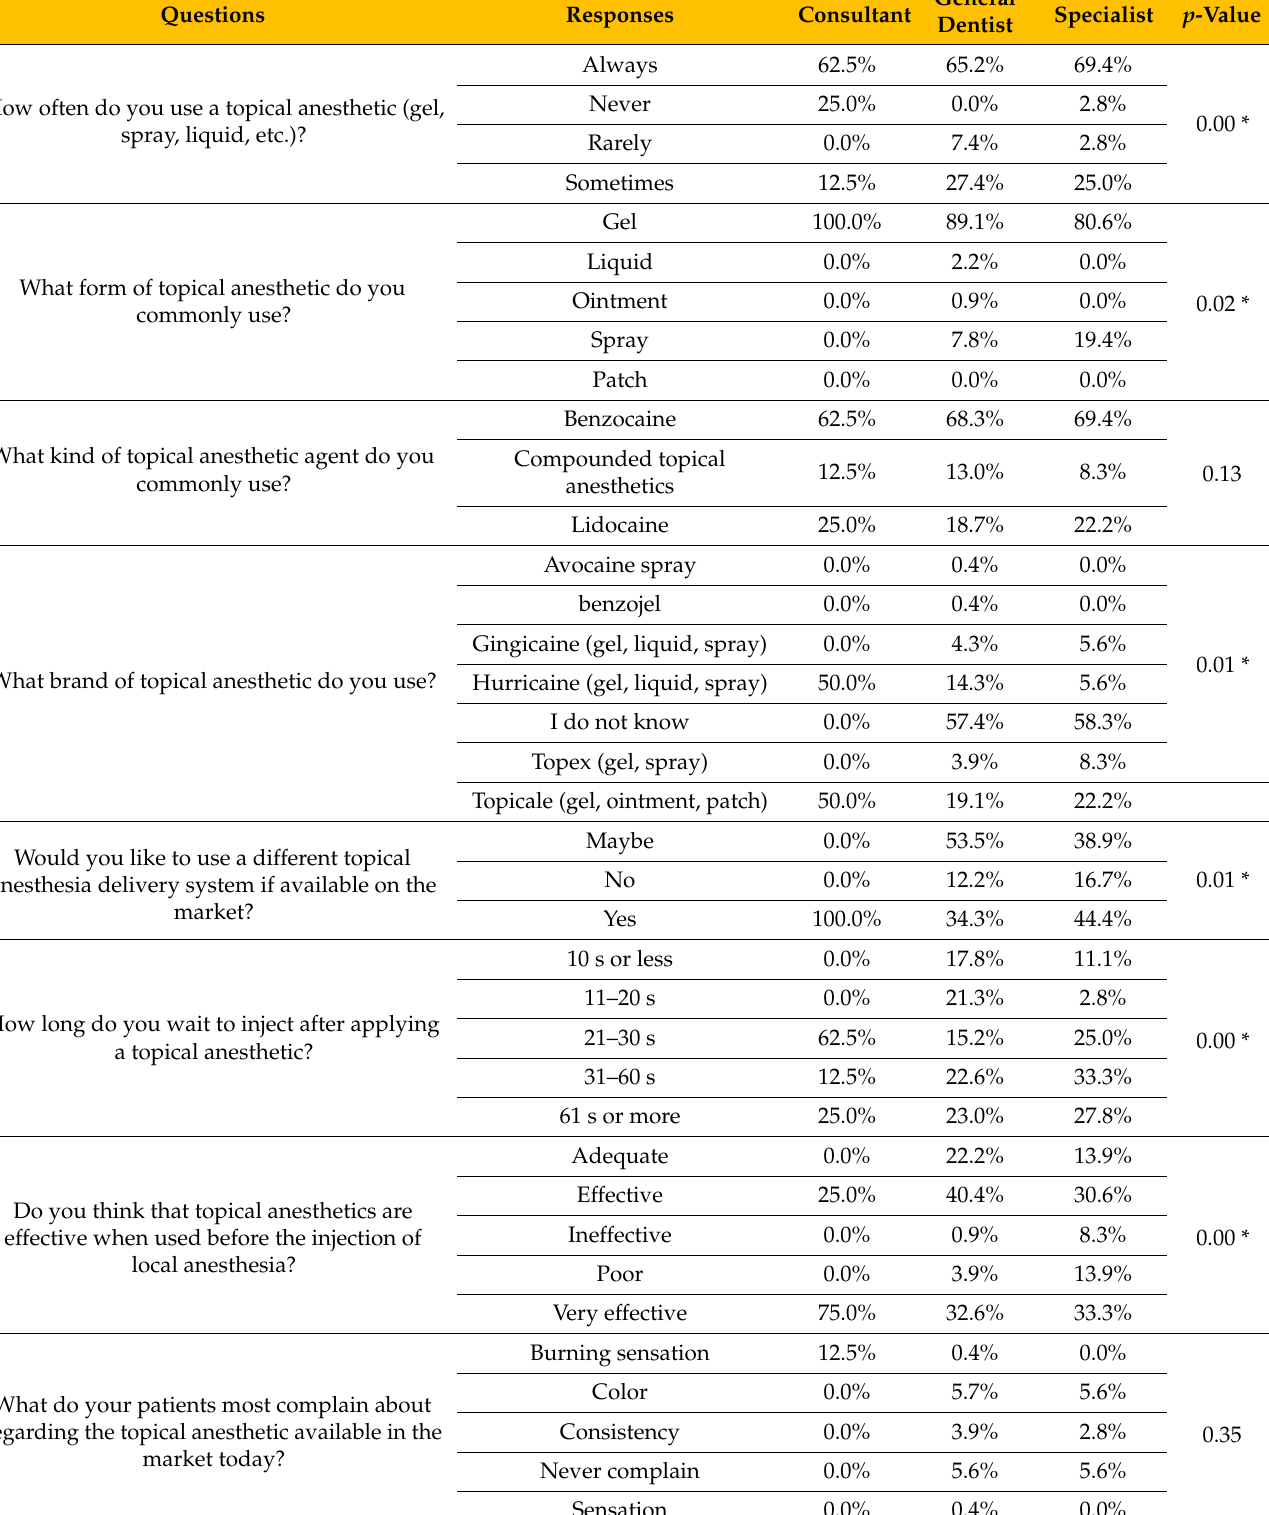
Table 6. Perceptions of topical anesthetics among Saudi dental practitioners based on